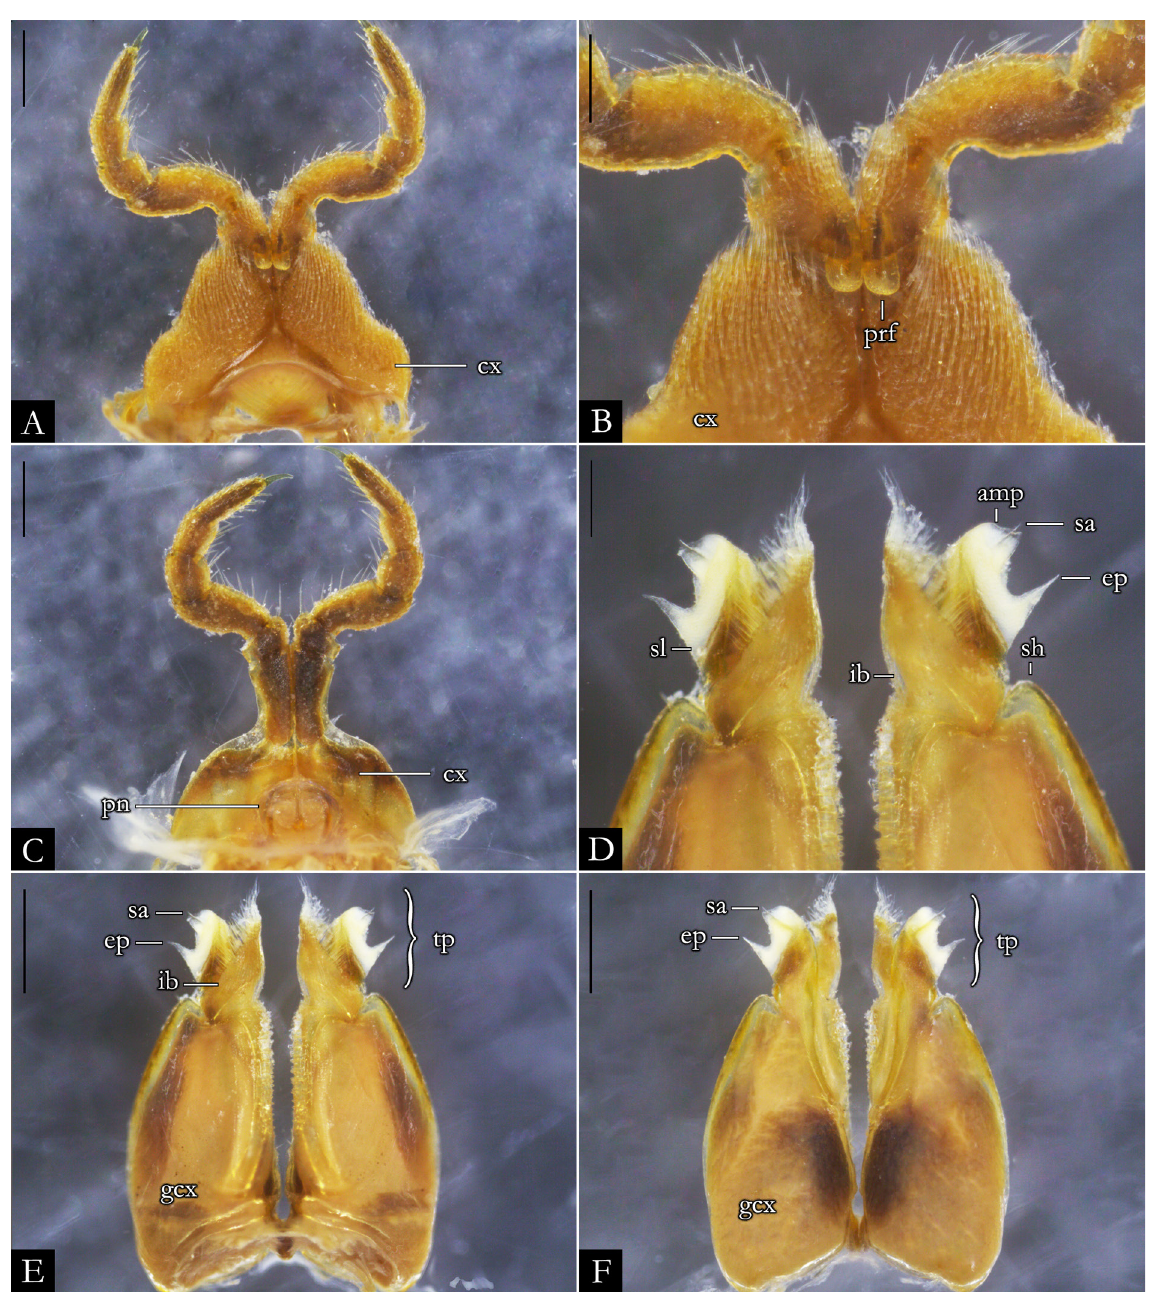
Fig. 148. Pseudonannolene aurea sp. nov., paratype, ♂ (IBSP 5854). A . First leg-pair. B . Detail of prefemur. C . Second leg-pair. D . Detail of telopodites, in anal view. E . Gonopods, in anal view. F . Gonopods, in oral view. Abbreviations: see Material and methods. Scale bars: A, C, E–F = 0.5 mm; B, D = 0.2